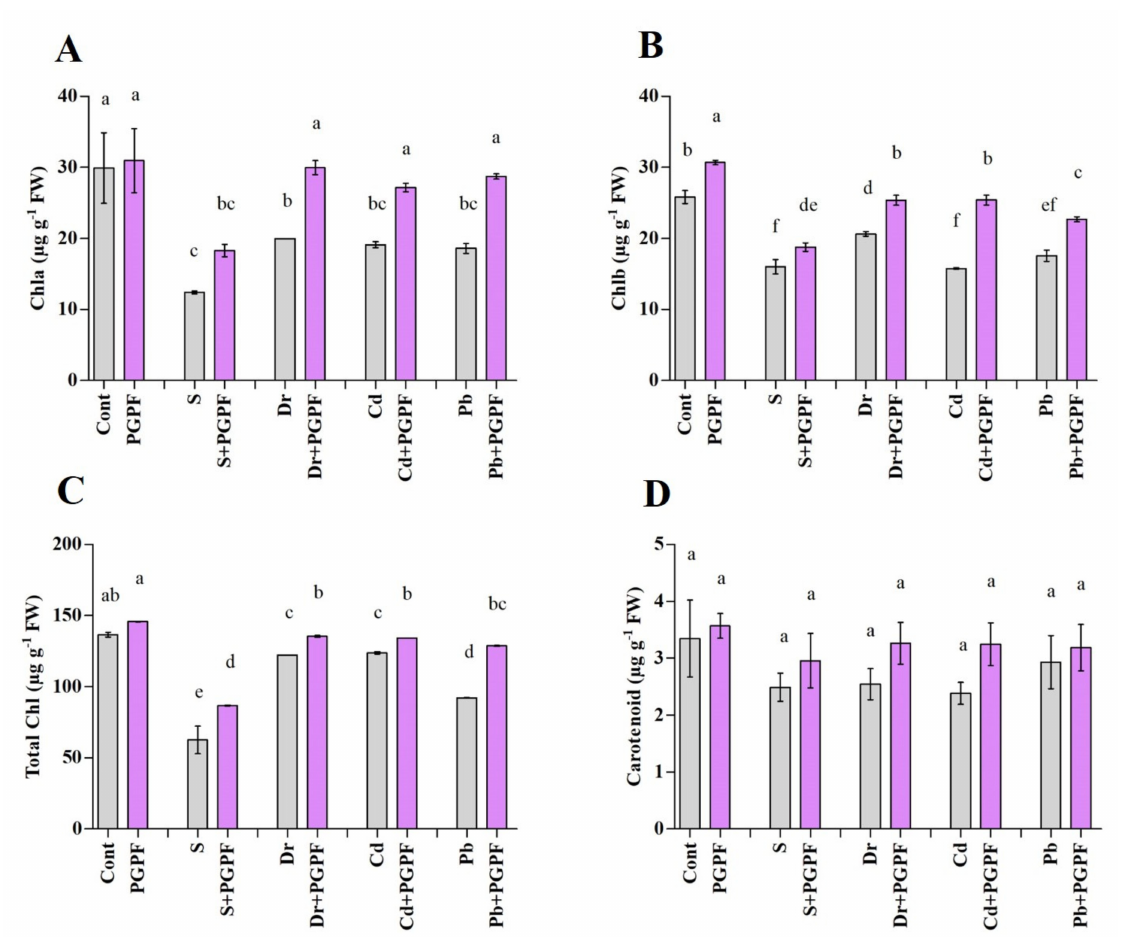
Figure 4. ( A ) chlorophyll a (Chla), ( B ) chlorophyll b (Chlb), ( C ) total chlorophyll (total Chl),